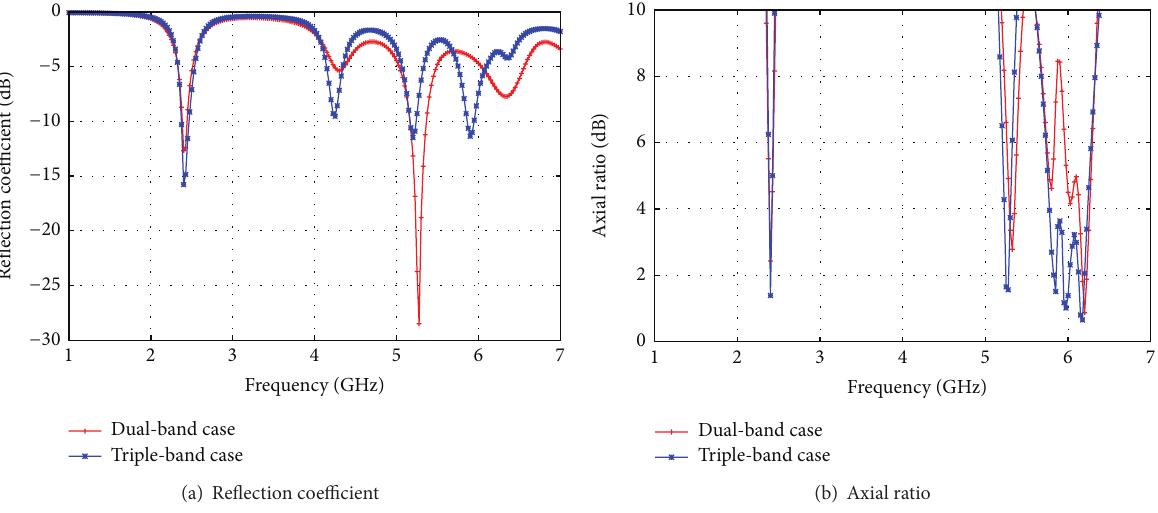
Figure 5: Dual- versus multiband microstrip-fed antennas S11 and axial ratio simulated